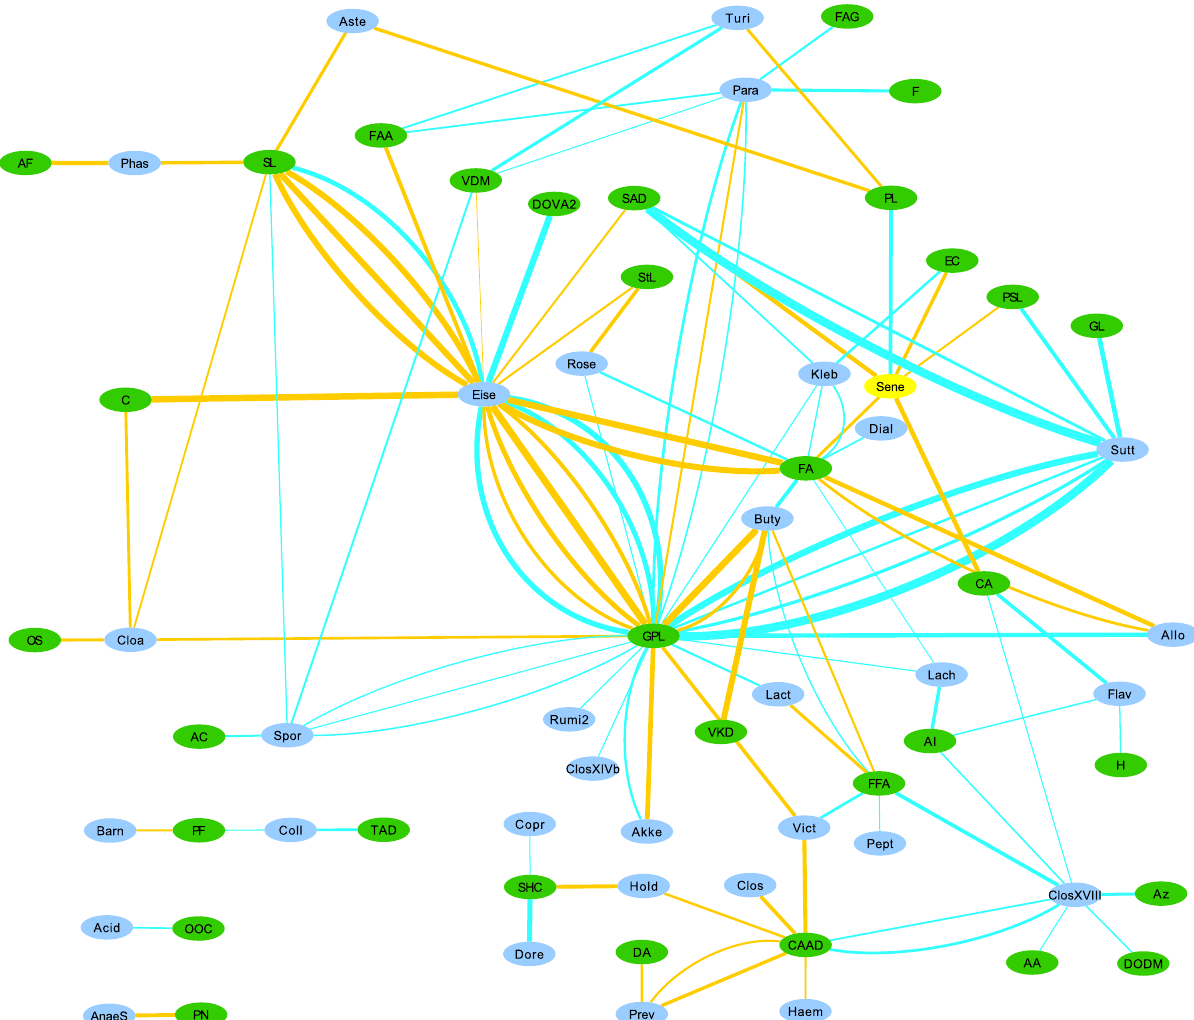
Fig. 1 Network of within-PD correlations. Network of within-PD correlations between bacterial genera and metabolite classes. Supplementary Tables 1 and 2 contain correlations with bins composed of more than one genus (or higher taxon), which were unclassi fi ed at genus level, but these bins were removed from Figs. 1 and 2 to aid in visualization and to focus on the identi fi ed genera. Edge thickness represents the strength of the correlation. Blue edges represent positive correlations, and Orange edges represent negative correlations. Green nodes represent metabolite classes and may contain more than one metabolite feature (hence why there may be multiple edges between two nodes), and Cyan nodes represent bacterial genera. Check Table 6 at the end of this article for the key to the abbreviations used in Figs. 1 and